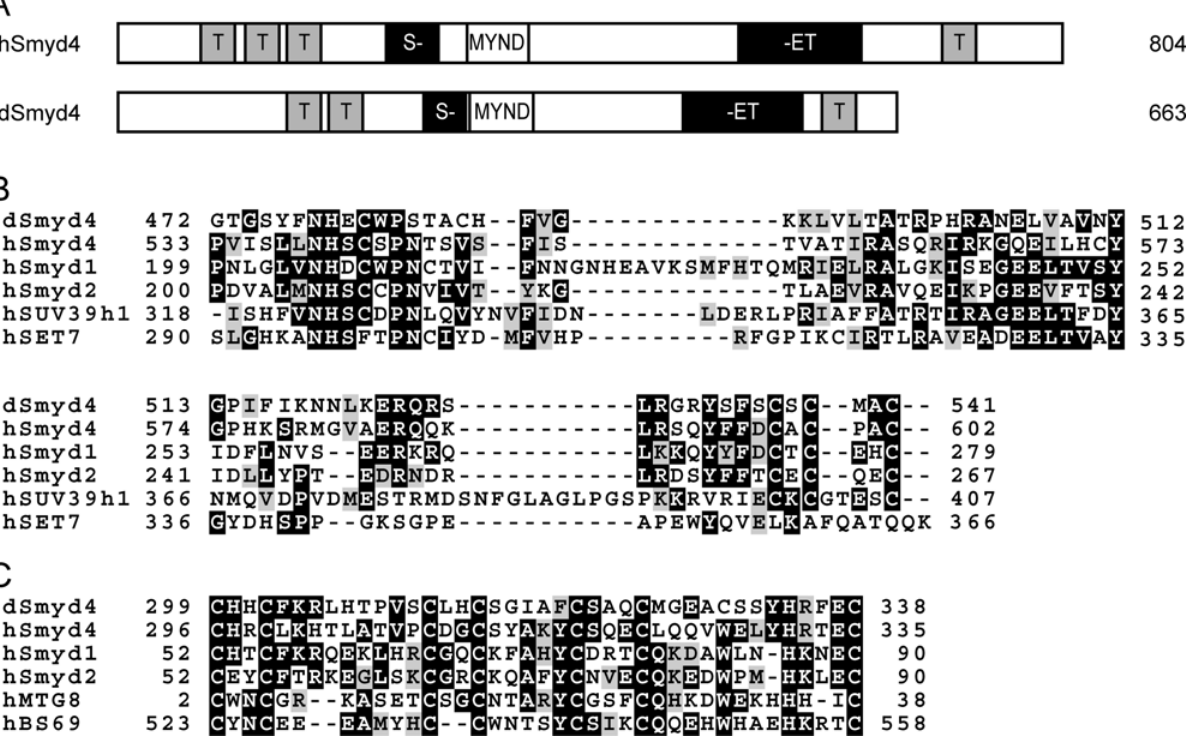
Figure 1. CG14122 is homologous to human Smyd4. A, Domain structure of human Smyd4 (hSmyd4) and Drosophila CG14122 (dSmyd4). T, tetratricopeptide repeat motif; S-, first part of the SET domain; MYND, MYND zinc fingers; -ET, second part of the SET domain, including cysteine-rich post-SET region. B, Alignment of the SET domains of dSmyd4 and human Smyd4, Smyd1, Smyd2, SUV39h1 and SET7. C, Alignment of the MYND domains of dSmyd4 and human Smyd4, Smyd1, Smyd2, MTG8 and BS69. In B and C identical residues are shaded black and similar residues are shaded grey.